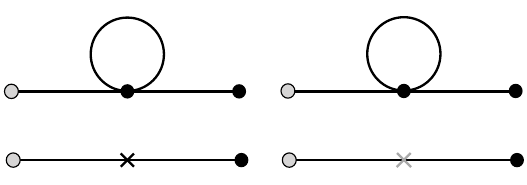
Figure 3 . (Top) One-loop contributions to the two-point correlation function in a λφ 4 theory. (Bottom) The corresponding δ m and/or δ r counterterm